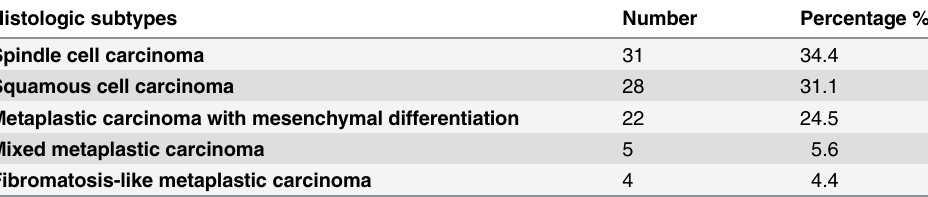
Table 3. Histologic subtypes of